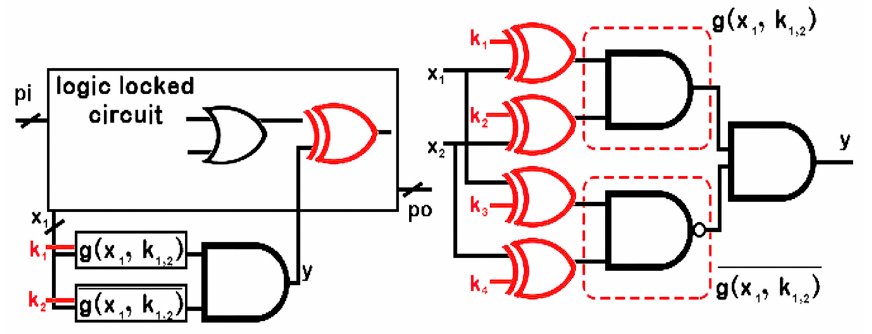
Figure 4. Complementary logic locks [5].